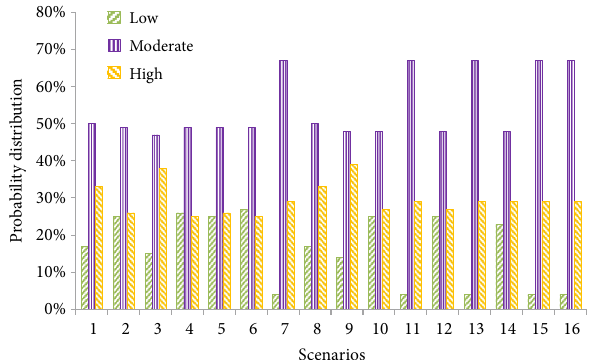
Figure 6. Probability distribution of project complexity of the predictive analysis under different scenarios